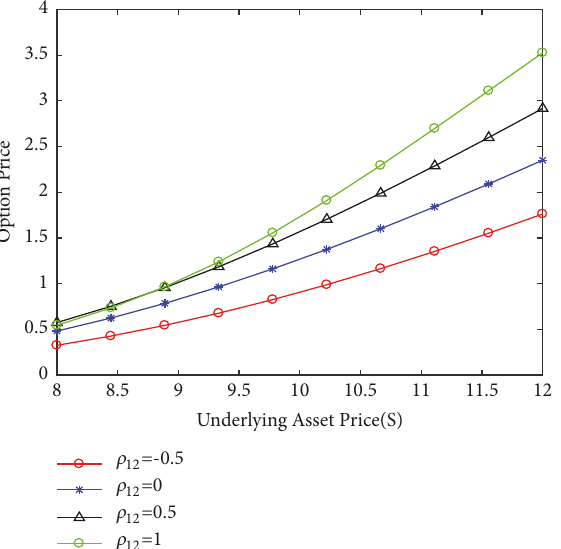
Figure 4: The influence of correlation coefficient 𝜌 12 on vulnerable call option with incomplete